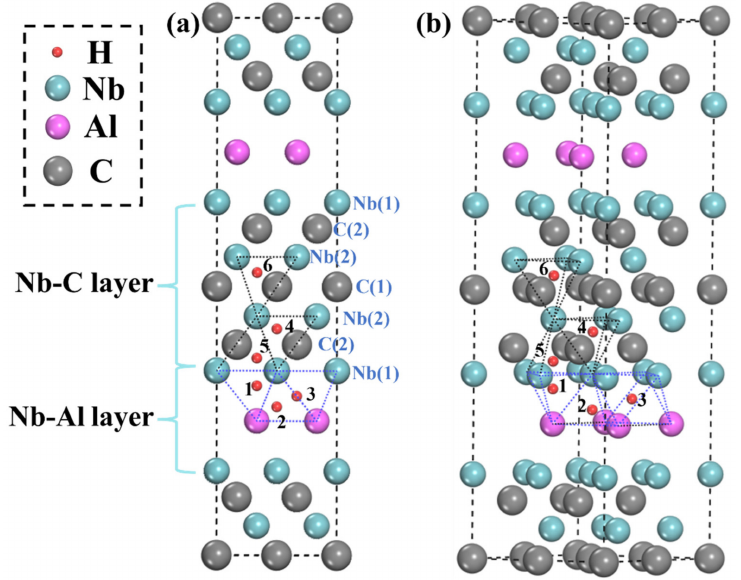
Figure 1. Crystal structure of Nb 4 AlC 3 and interstitial sites considered in this work: ( a ) Front view; ( b ) side